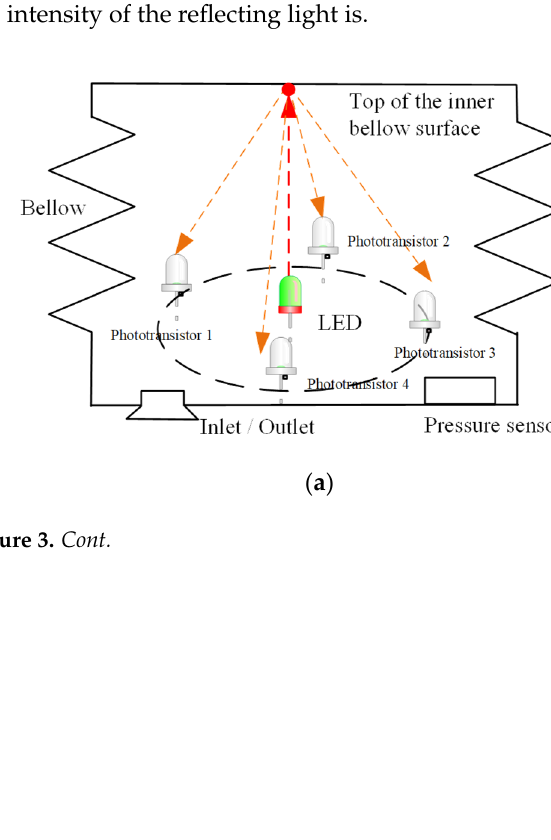
Figure 2. Manufacturing process of the module (left: casting, right: part of the inside surface). ( a ) Mold, ( b ) white inside, and ( c ) dimensions of the bellow (in mm).